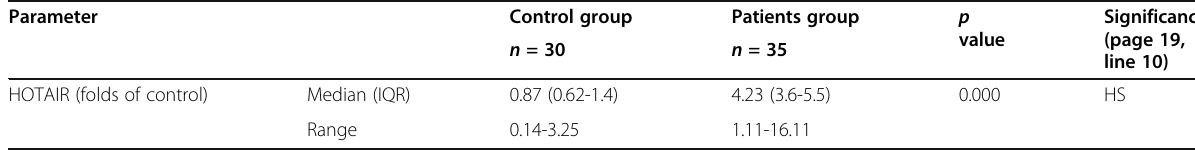
Table 3 HOTAIR expression in both AML patients and control groups Parameter